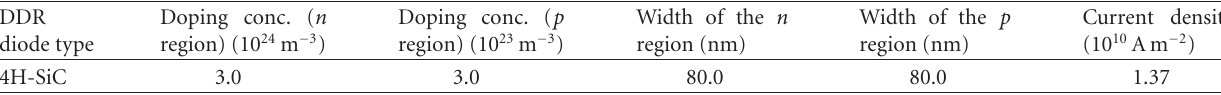
Table 1: Design parameters of 4H-SiC impatt at thz